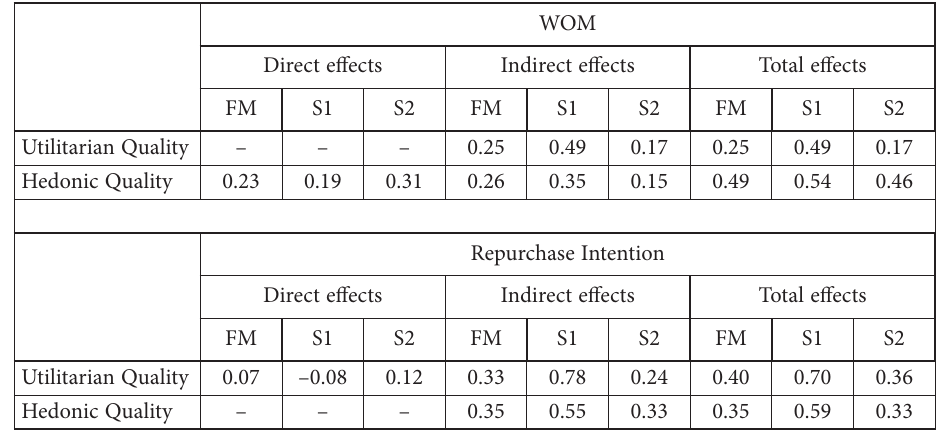
Table 10. Direct and indirect effects of utilitarian and hedonic